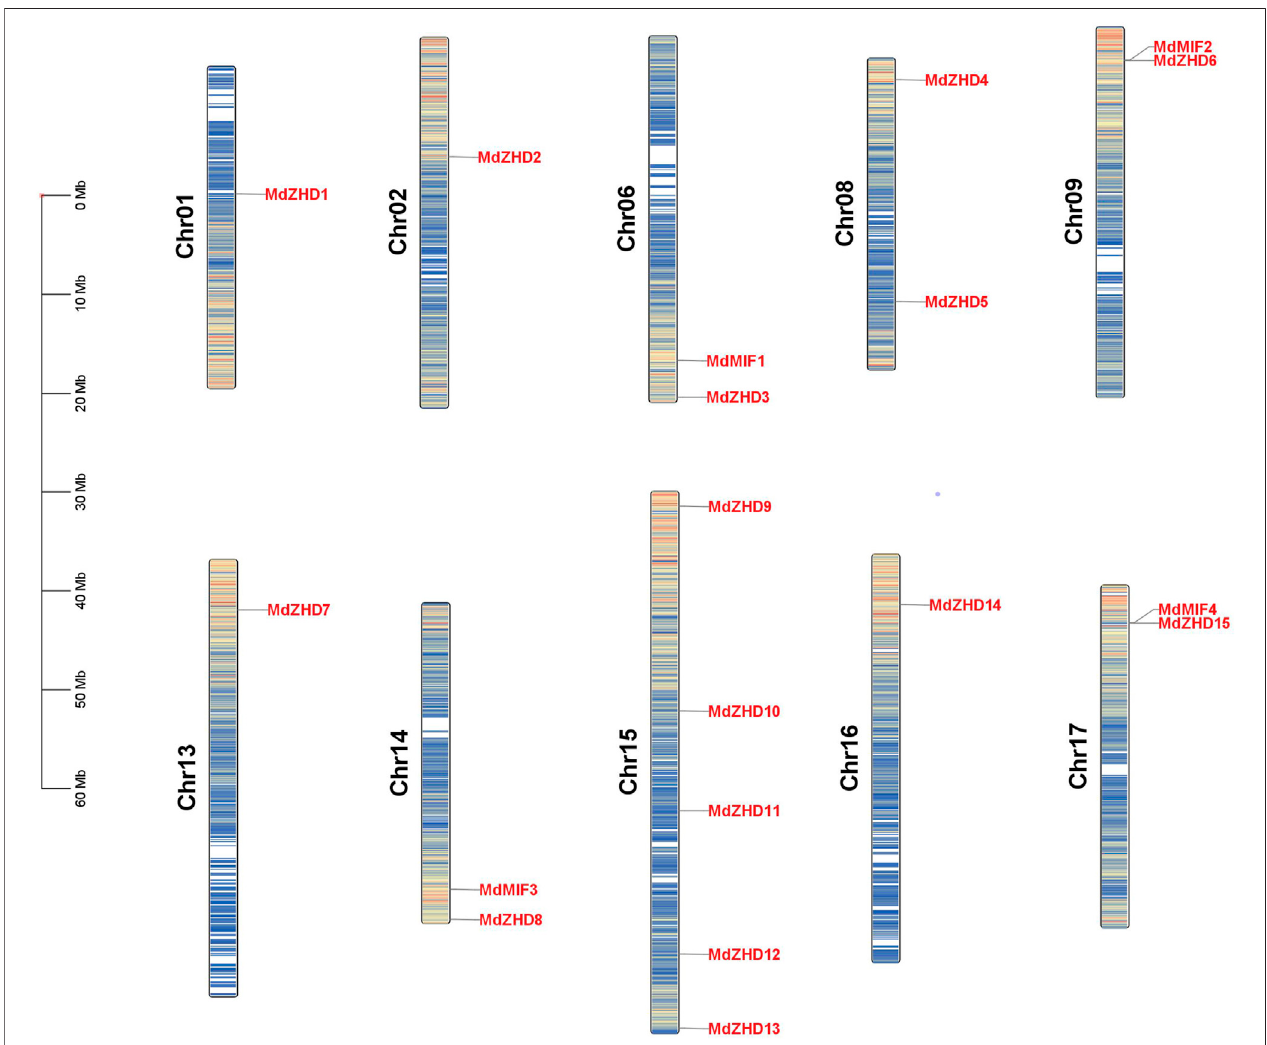
FIGURE3| Distribution of MdZF-HD genesalongapplechromosomes.Thescaleontheleftstands forthelengthofeach chromosomeshown inmega base(Mb).